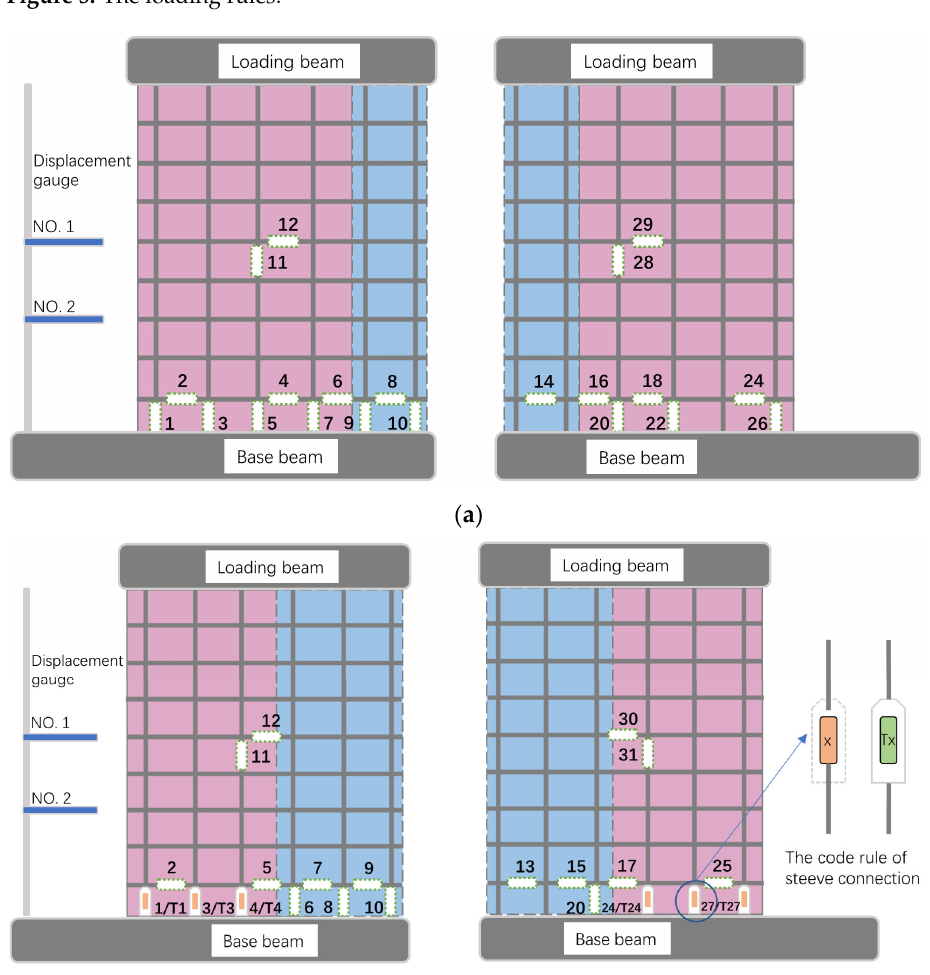
Figure 6. Measuring Instruments for the specimens. ( a ) The specimens L−1, L−2 and L−3. ( b ) The specimens TL−1.